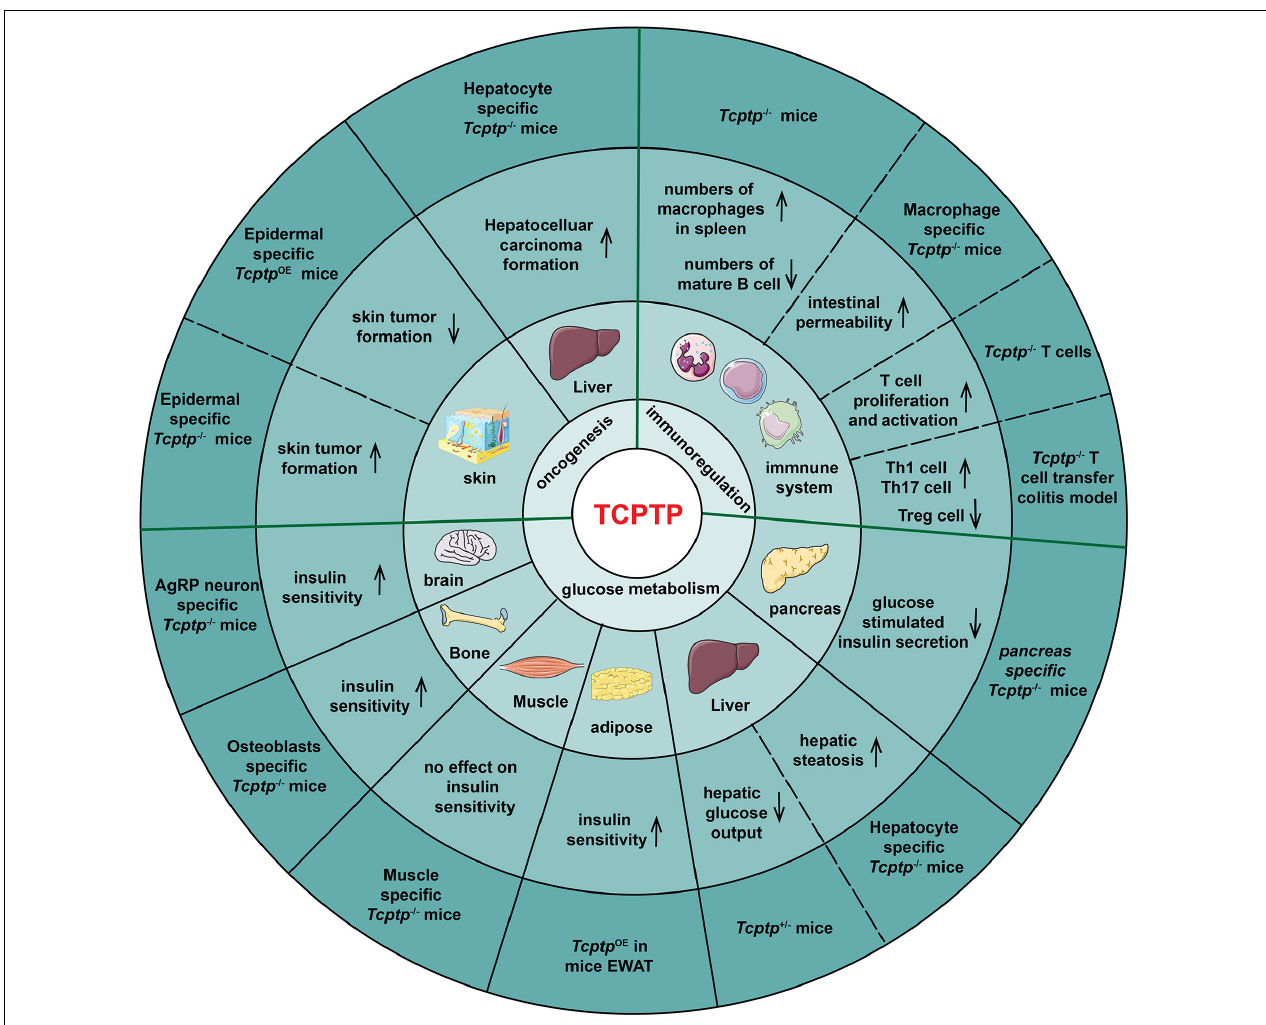
FIGURE 3 | TCPTP-mediated biological processes in different tissues and organs. The experimental models, the resulting effects, the tissues or organs and the biological functions of TCPTP are presented from the outside to the inside of the pie chart. OE indicates